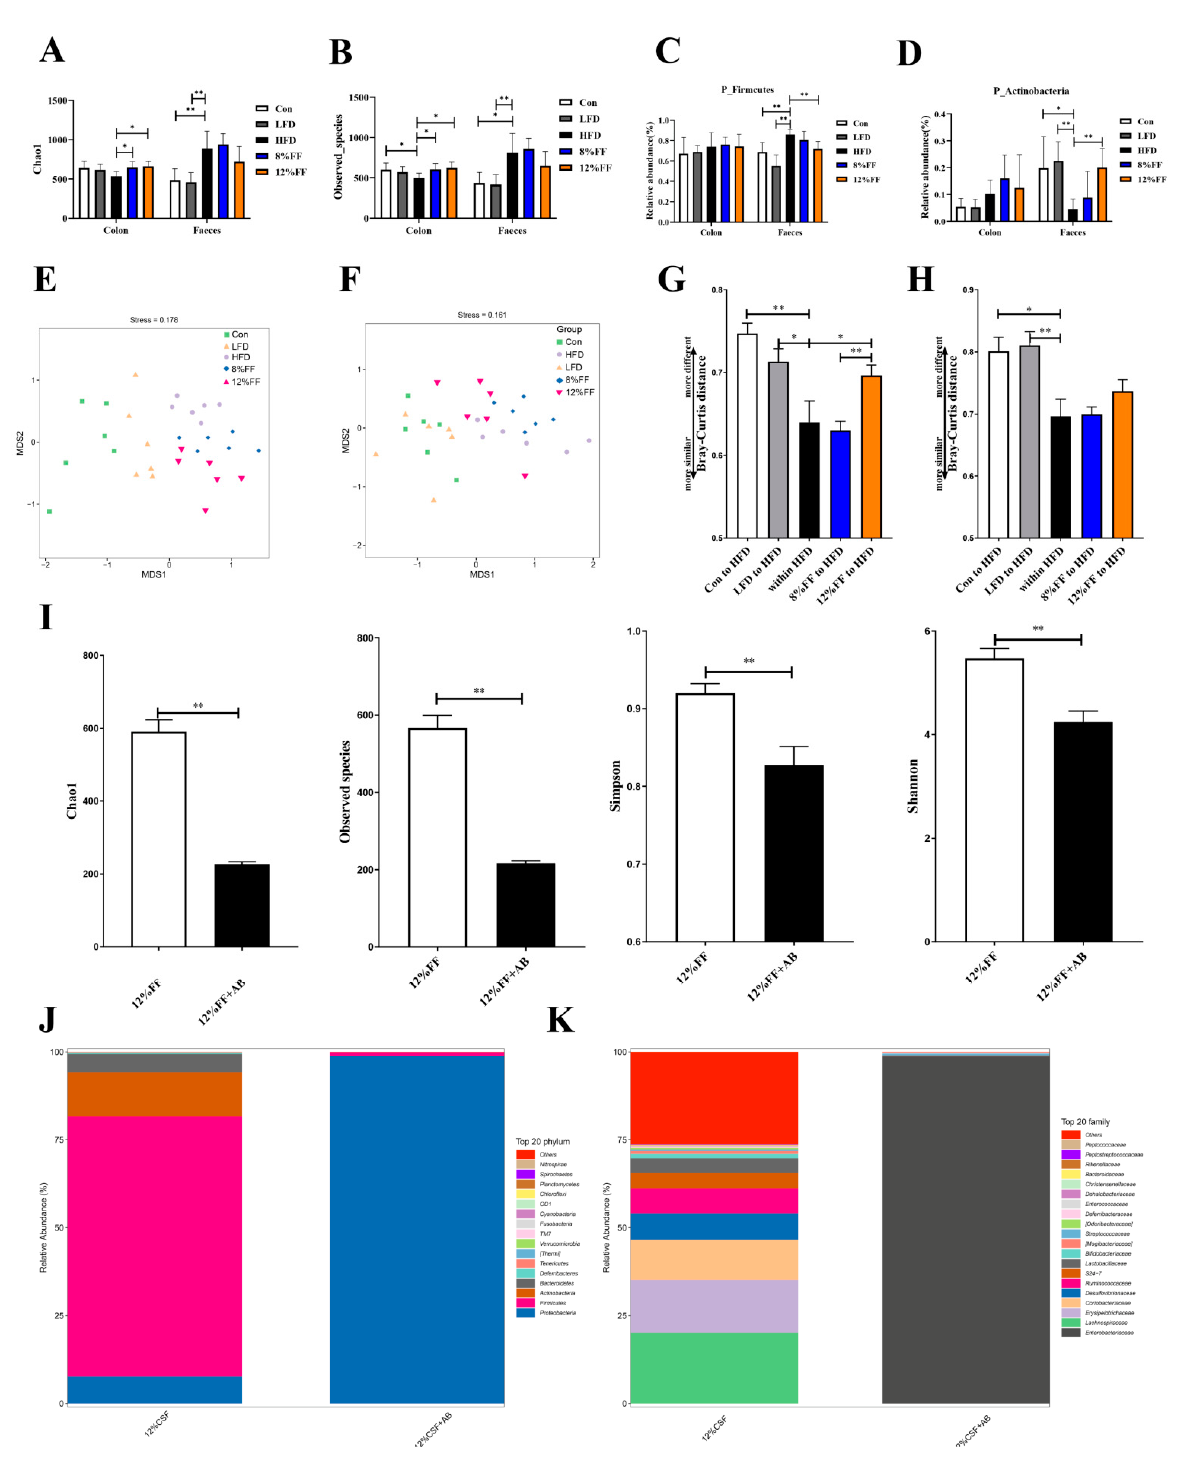
Figure 5. Effects of functional fiber on α and β diversity of gut microbiota, and effects of antibiotics on the gut microbiota in obese mice. ( A , B ) Chaol and Observed species index ( n = 6). ( C , D ) The abundance of Firmicutes and Actinobacteria ( n = 6). ( E , F) The principal component analysis (PCA) of colon and fecal samples ( n = 6). ( G ) Bray–Curtis distance between colonic microbiomes ( n = 6). ( H ) Bray–Curtis distance between fecal microbiomes ( n = 6). ( I ) Chao1, Observed species, Simpson, and